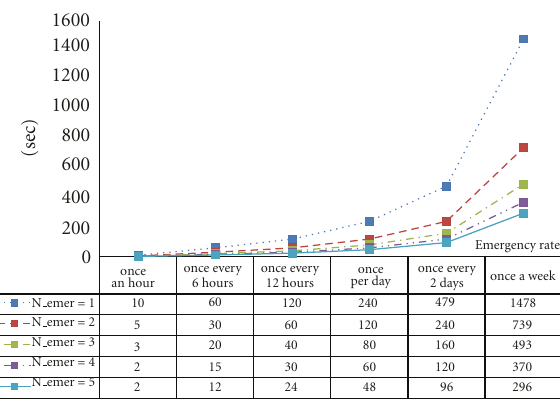
Figure 10: Overhead time of unused EGTS with BI = 62ms.